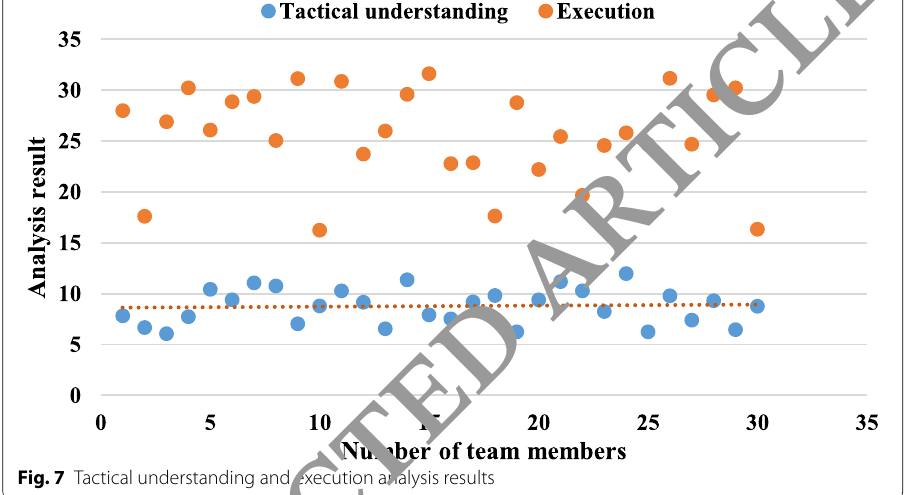
Fig. 7 Tactical understanding and execution analysis